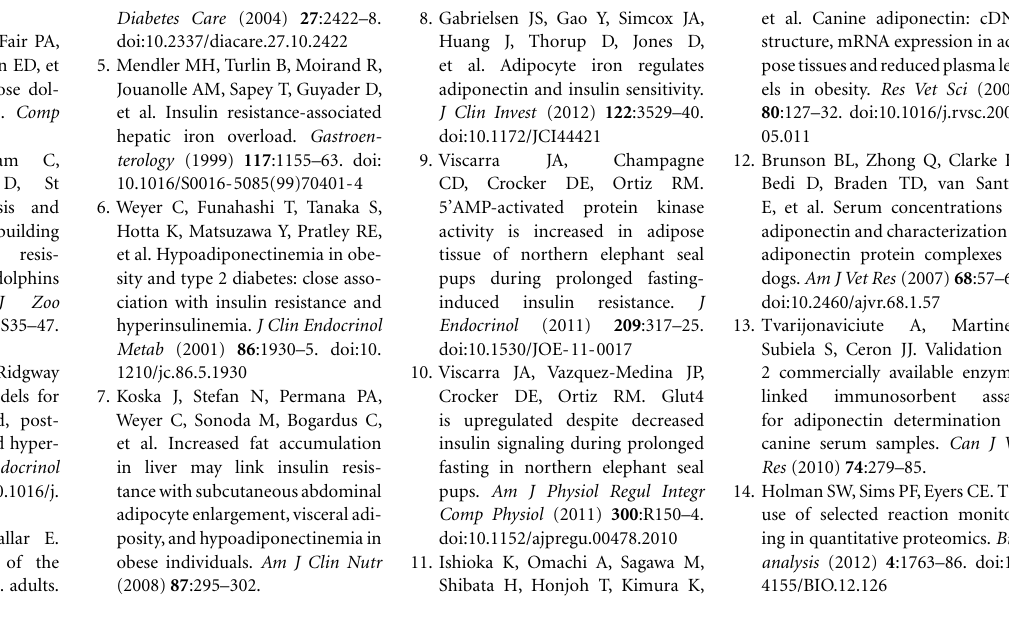
Figure S1 | Fragmentation tables of three synthetic isotopically labeled target peptides along with observed fragment ions .Tables of fragment ion m/z is shown for each peptide (generated using the Institute for Systems Biology online Fragment Ion Calculator; http://db.systemsbiology.net/ proteomicsToolkit/index.html). Observed fragment ions with highest peak intensities are labeled in MS/MS spectra, and colored red in tables. Figure S2 | External calibration curves for yl3 2 + from IFYNQQSHYDGTTGK . The solid line represents the 1/x weighted linear regression, R =0.99181. Inset is provided to show performance at lower concentrations.